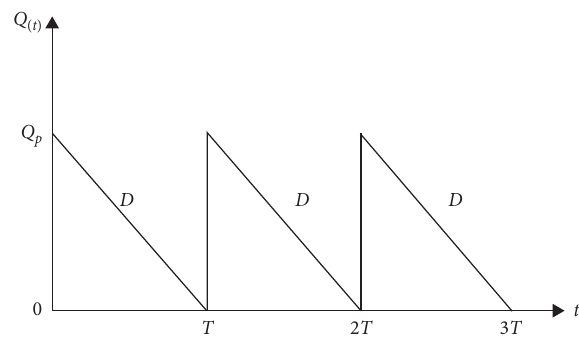
Figure 1: Crisp inventory